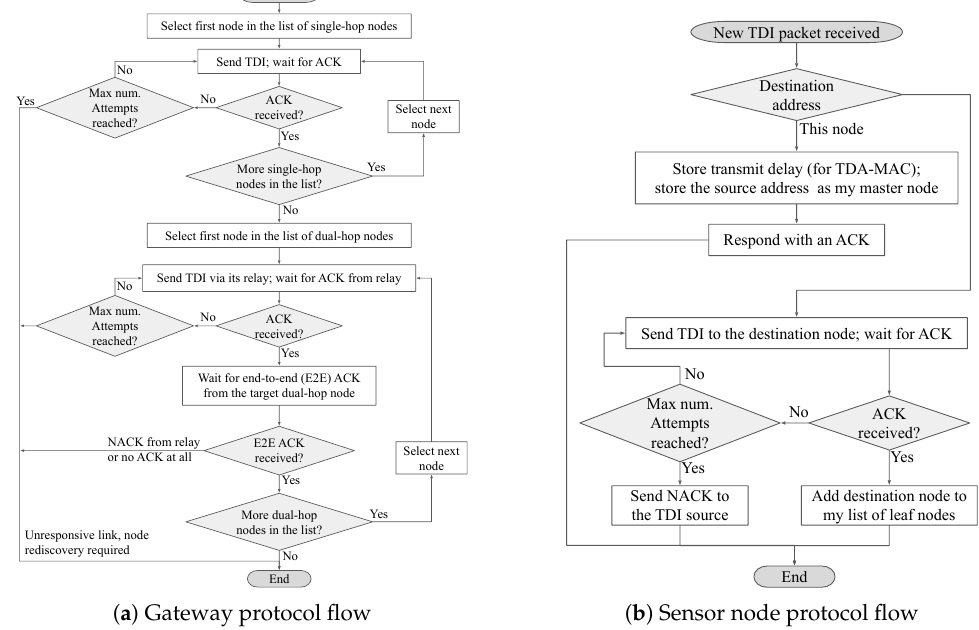
Figure 3. Overview of the network setup procedure. ( a ) Gateway protocol flow; ( b ) Sensor node protocol